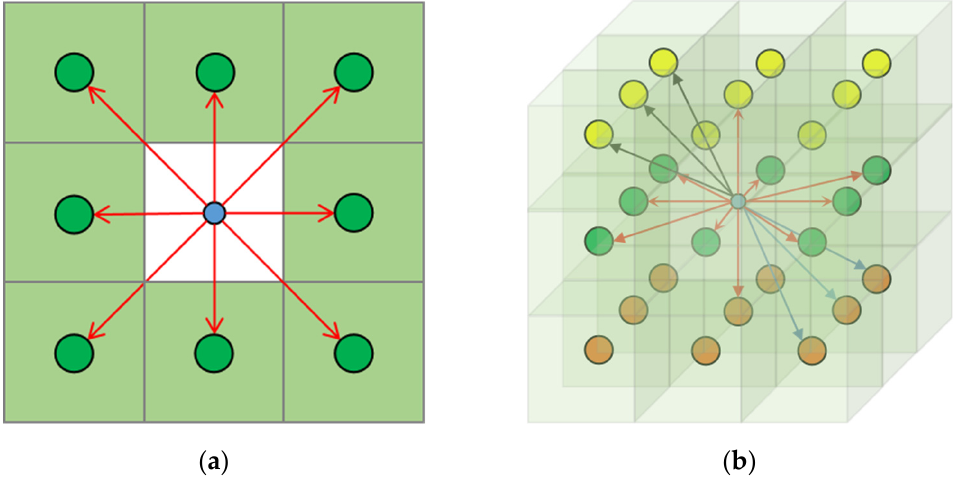
Figure 6. Minimum set of JPS algorithm in 2D and 3D space. ( a ) 2D JPS path search minimum set. ( b ) 3D JPS path search minimum set.